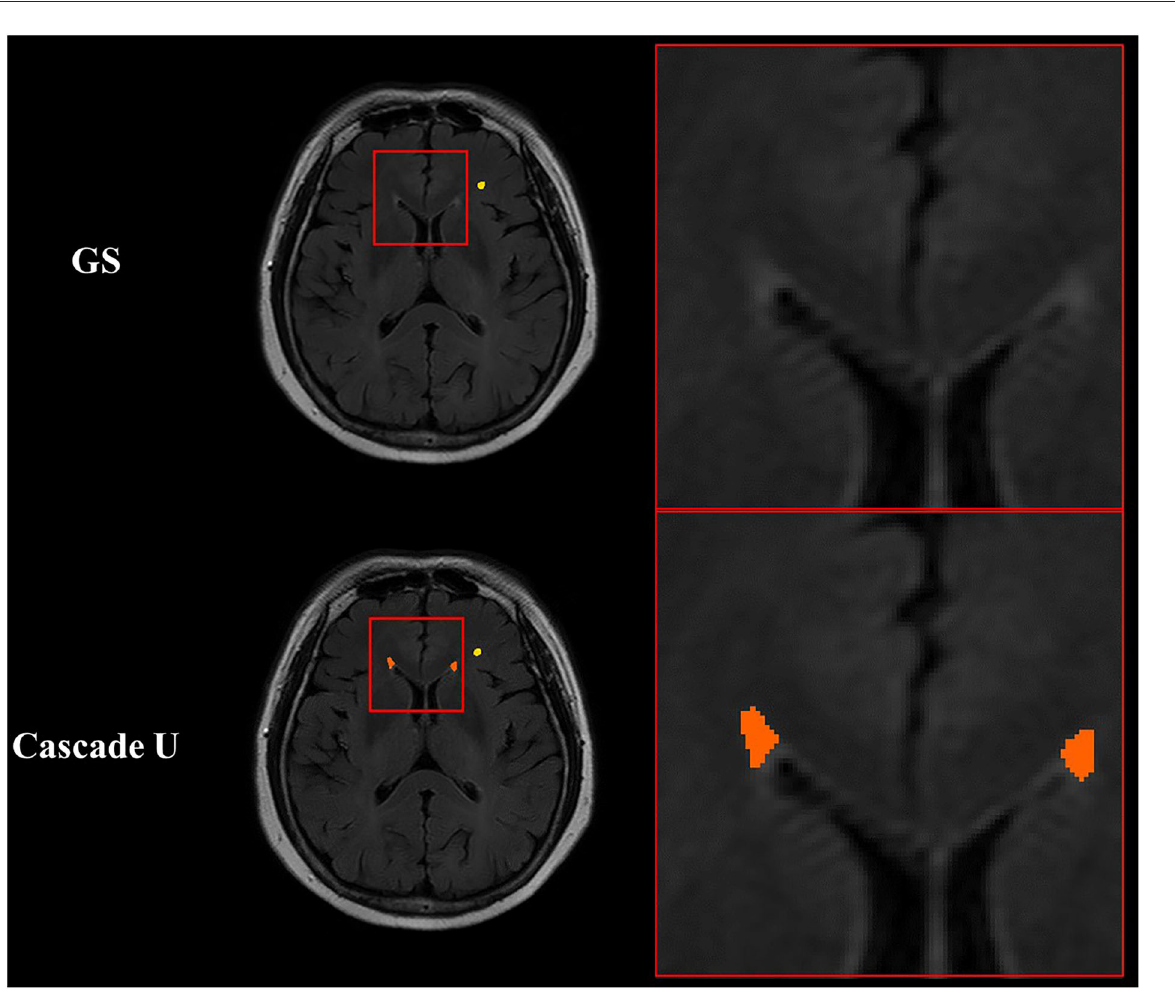
FIGURE7 Illustration of segmentation results of Cascade U with pvWMHs Fazekas score of 0. Orange represented pvWMHs, and yellow represented dWMHs. GS, gold standard.